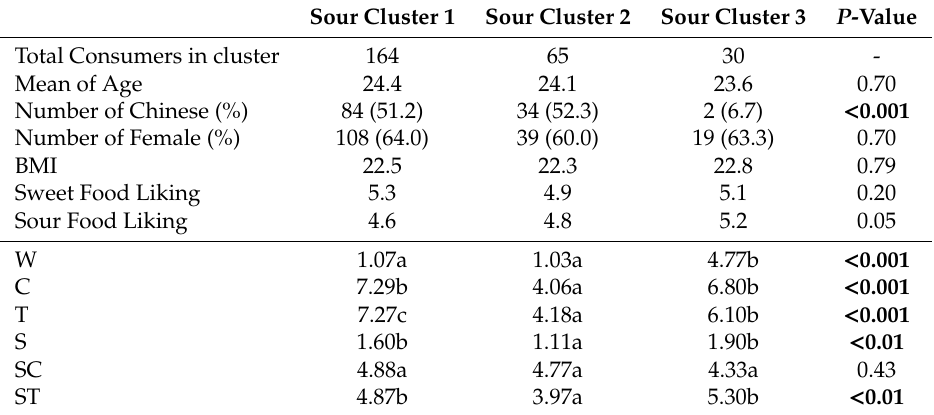
Table 7. Cluster characteristics and means of ratings for Sourness Intensity in clusters. Samples are Water (W), Citric acid (C), Tartaric acid (T), Sucrose (S), Sucrose and Citric acid (SC), and Sucrose and Tartaric acid (ST). P -values for cluster culture and gender are for χ 2 analysis of di ff erence, whereas p -values for Age, BMI, and Sweet and Sour Food Liking are from ANOVA. P -values for Sourness Intensity are from mixed model Analysis of Variance. Letters are to be read row wise, and indicate significant di ff erences between samples based on Honest Significant Di ff erences (HSD). Significant e ff ects ( p ≤ 0.05) are marked in bold. Sour Cluster 1 Sour Cluster 2 Sour Cluster 3 P -Value Total Consumers in cluster 164 65 30 - Mean of Age 24.4 24.1 23.6 0.70 Number of Chinese (%) 84 (51.2) 34 (52.3) 108